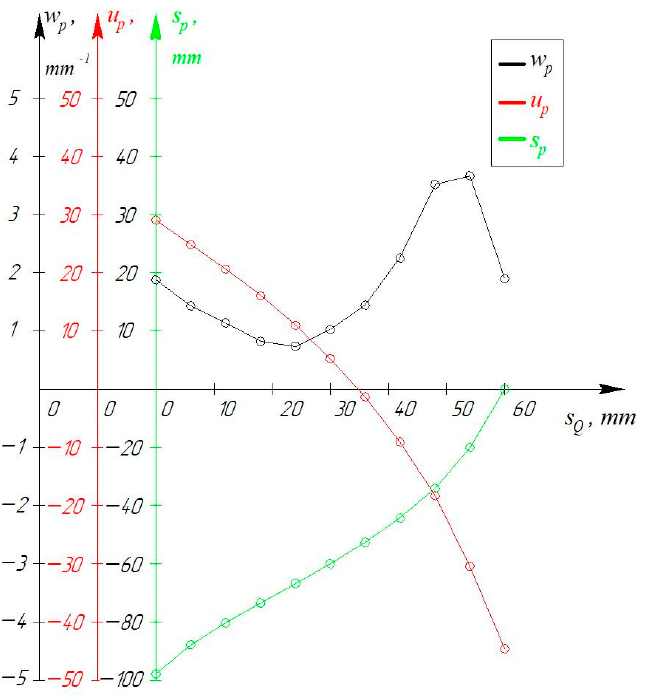
, u P , w P are shown in Figure 8. i i i